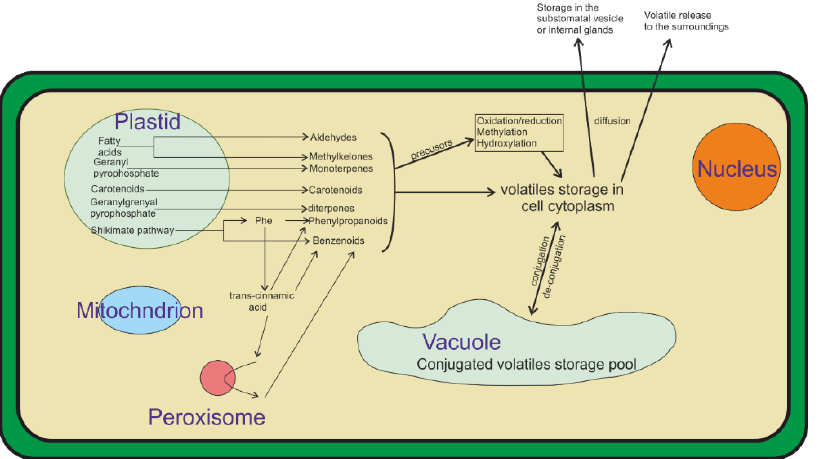
Figure 2. Most plant volatiles are derived from four biosynthetic classes: aromatics, fatty acid, terpenoids, and amino acids. Volatiles are produced from fatty acids via oxidative cleavage. Several of these products are modified to be more lipophilic prior to release through the masking or removing of hydrophilic functional groups through methylation or reduction reactions. Figure modified from [28].